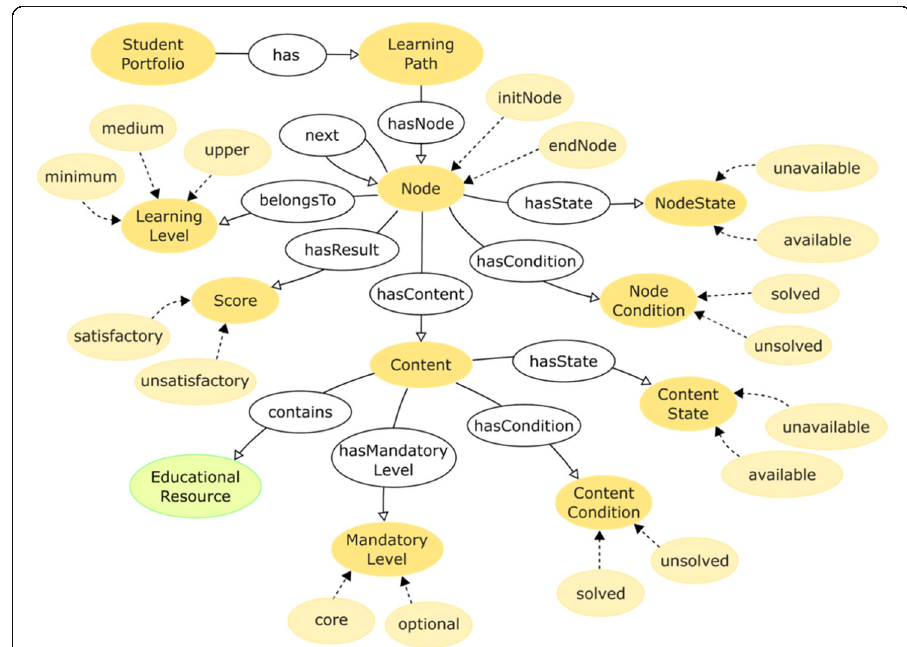
Fig. 6 Learning Path